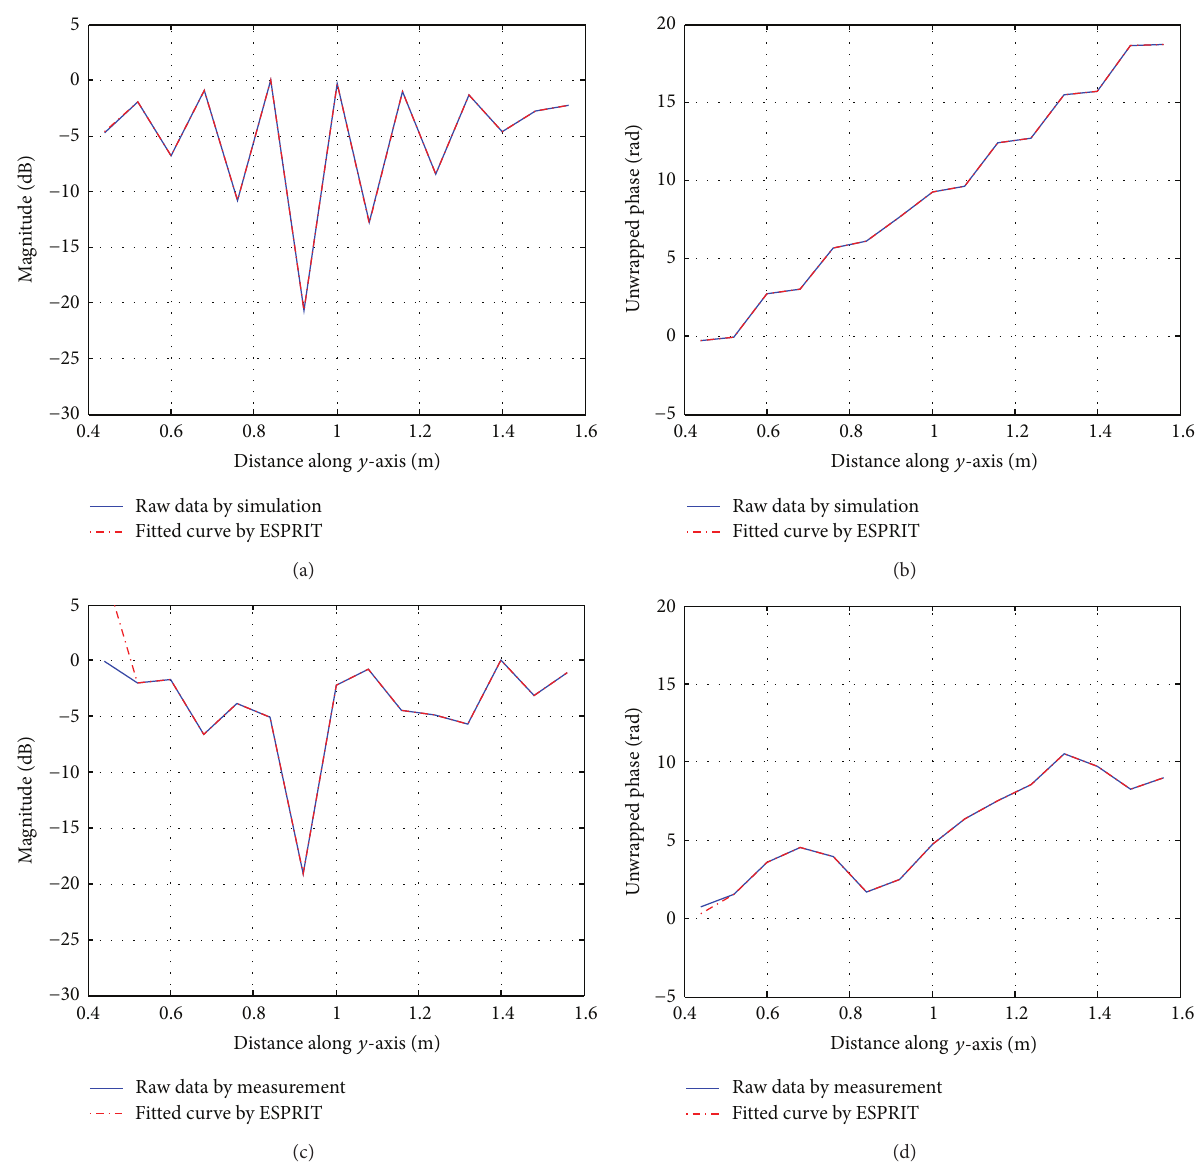
Figure 5: Comparison between original data with fitted results by ESPRIT: (a) simulated magnitude at 390 MHz; (b) simulated unwrapped phase at 390 MHz; (c) measured magnitude at 370 MHz; (d) measured unwrapped phase at 370